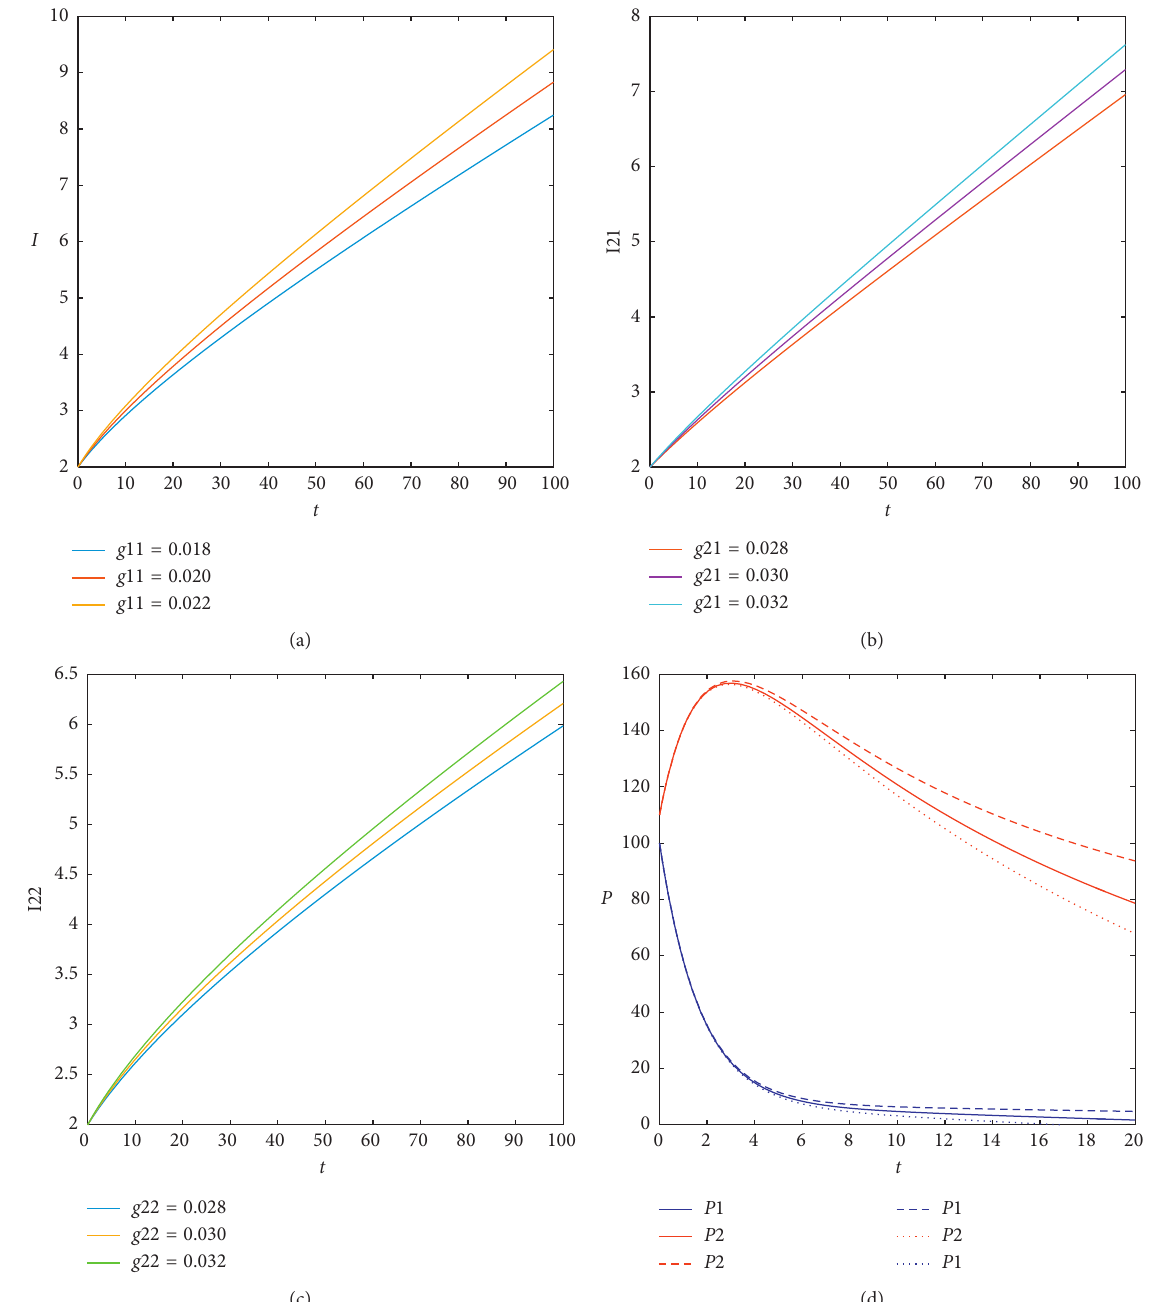
Figure 7: Sensitivity analysis of pollution abatement levels and pollution